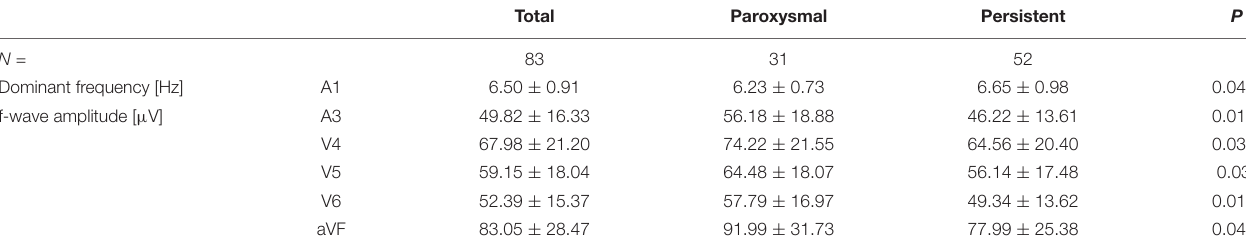
TABLE 3 | Differences for f-wave parameters in comparison of patients with paroxysmal and persistent AF.